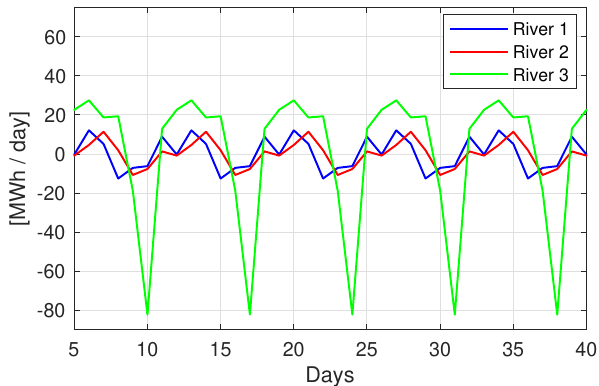
Figure 6. Seasonal component of 3 plants on different